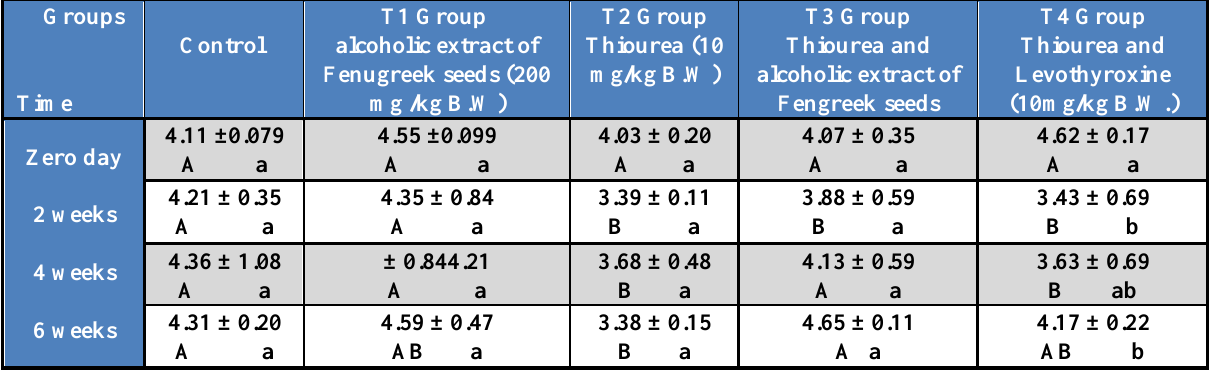
Table, 4: Effect of alcoholic extract of fenugreek seeds, thiourea and levothyroxine on (WBC) concentration (Cell x 10 3 /L) in adult male